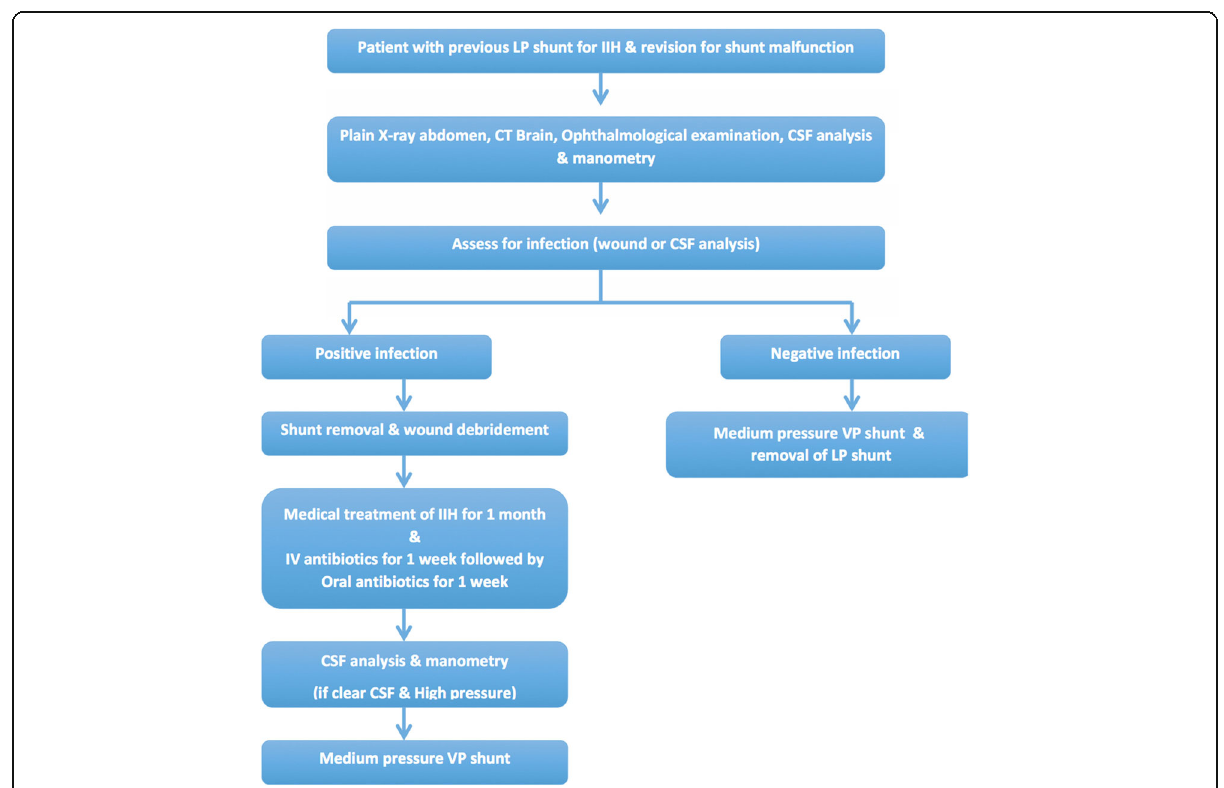
Fig. 1 Algorithm for treatment of failed LP cases with